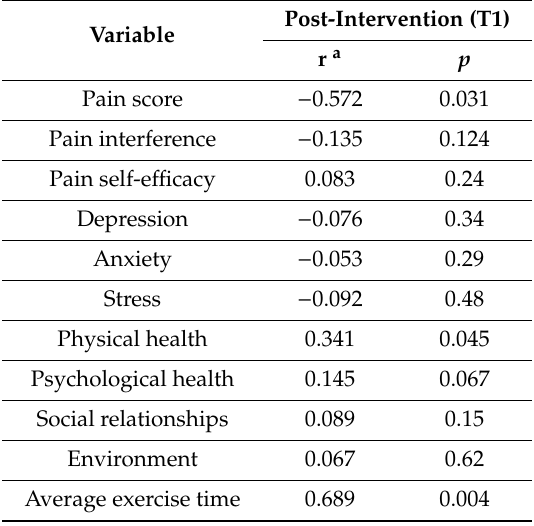
Table 5. Correlation between the frequency of using digital tools and the outcome variables.